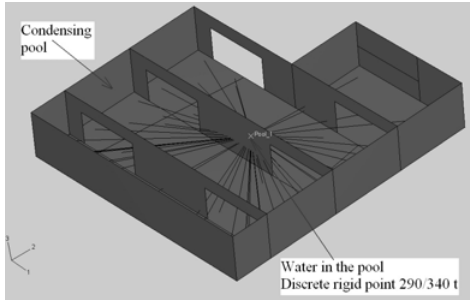
Fig. 5. Modelling the water mass in the condensing pools